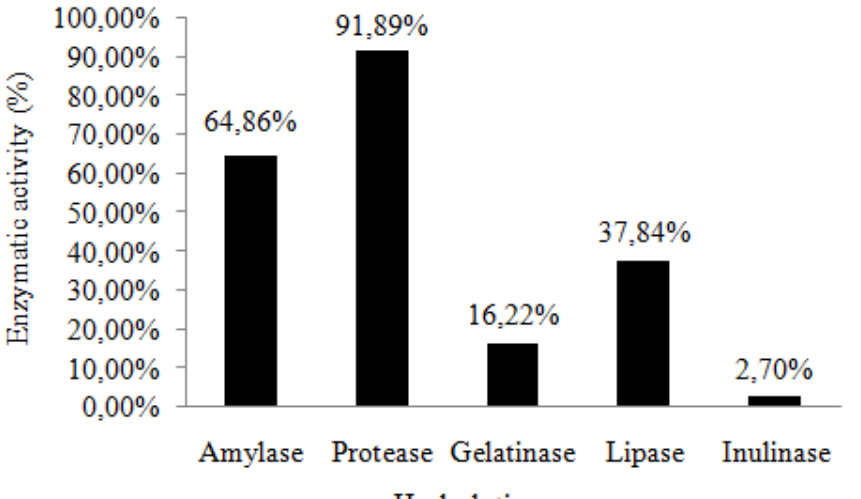
Figure 1. Production of extracellular enzymes by the 37 bacterial isolates found in the sediment samples from Imperatriz Leopoldina Municipal Natural Park, São Leopoldo, Brazil. Values into the bars indicate the number of isolates positive for the respective enzymatic